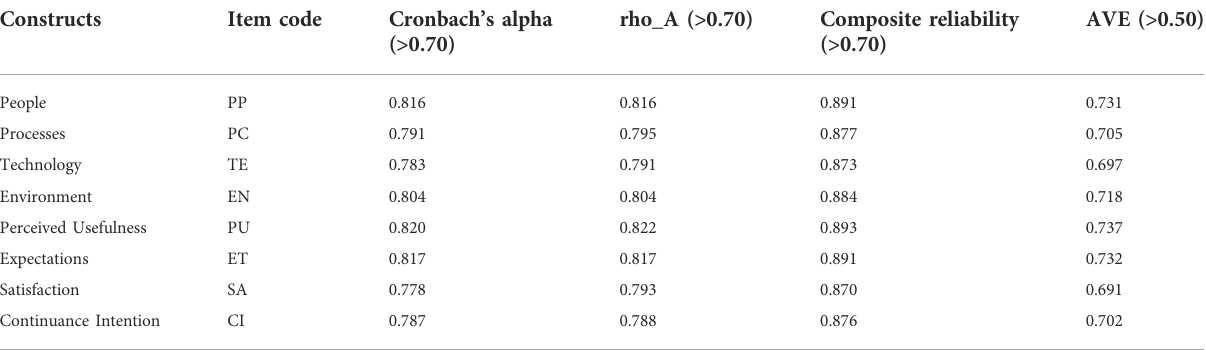
TABLE 2 Establish the reliability and